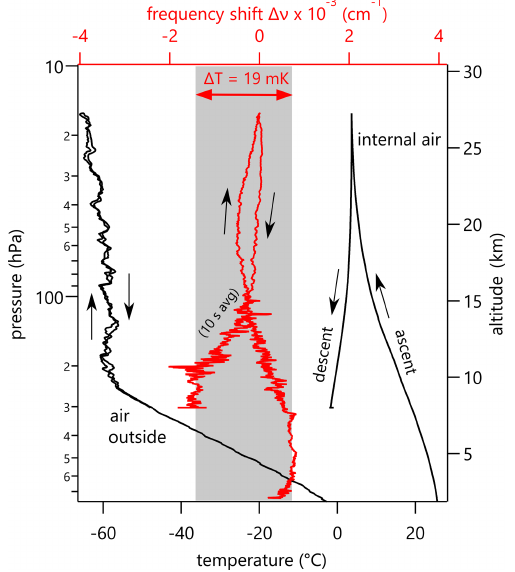
Figure 4. Temperature measurements during the first balloon flight in the UTLS demonstrating the thermal stability of the instrument. The laser temperature variation is derived from its detuning, i.e., the change of the absorption line’s central frequency (red, top axis), in- dicating a maximal temperature drift of 19mK. The internal and external air temperatures are shown in black on the bottom axis for comparison. The pronounced variability of the laser tempera- ture around the tropopause (300–100hPa) is caused by the fitting procedure of the central frequency of the absorption line rather than effective temperature